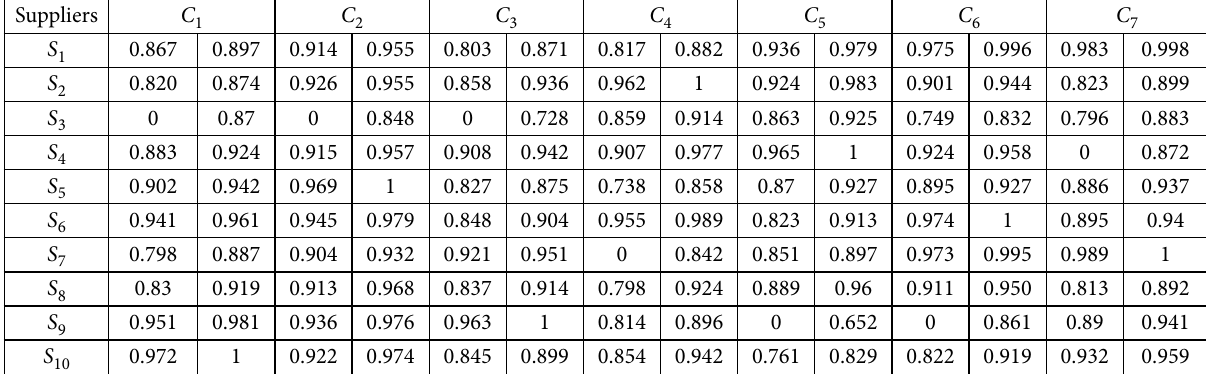
Table 12. The normalized weighted power matrix for